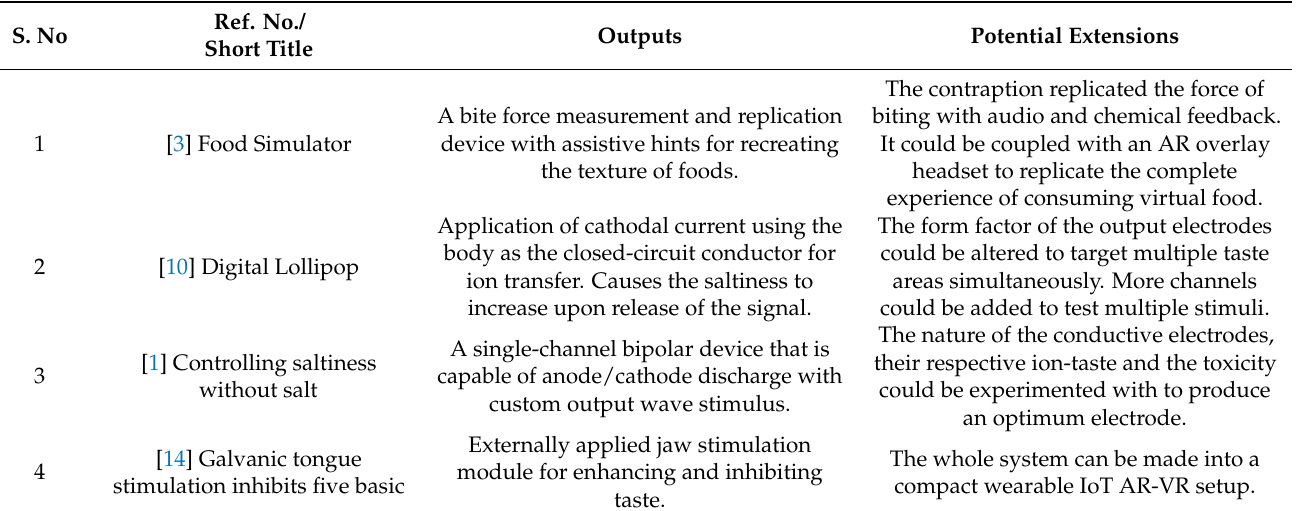
Table 1. A brief overview of the key publications on the development of the gustatory sensor module’s